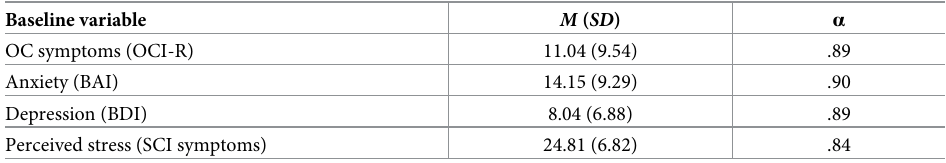
Table 1. Means, standard deviations, and Cronbach’s alpha of the baseline